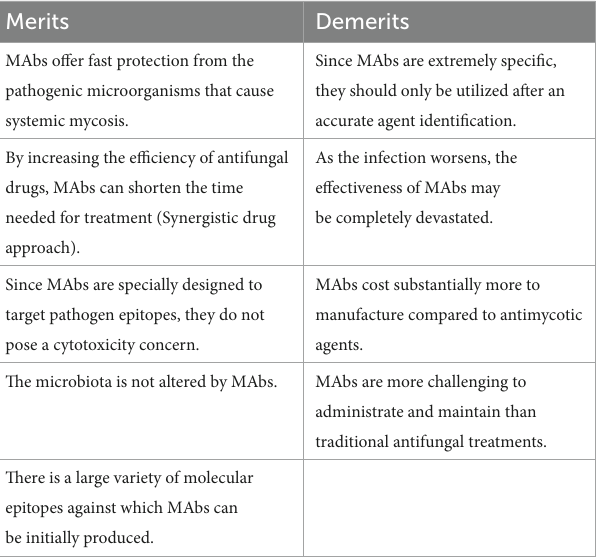
TABLE 2 Merits and demerits of treating systemic mycoses with therapeutic monoclonal antibodies (140). Merits